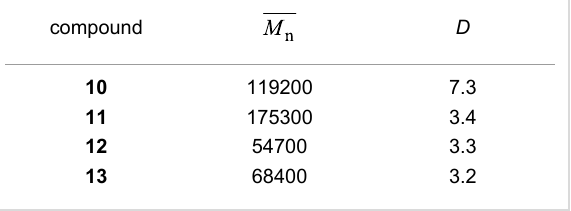
Table 3: Molecular weights of the polymers 10 – 13 after dialysis at 45 °C. compound